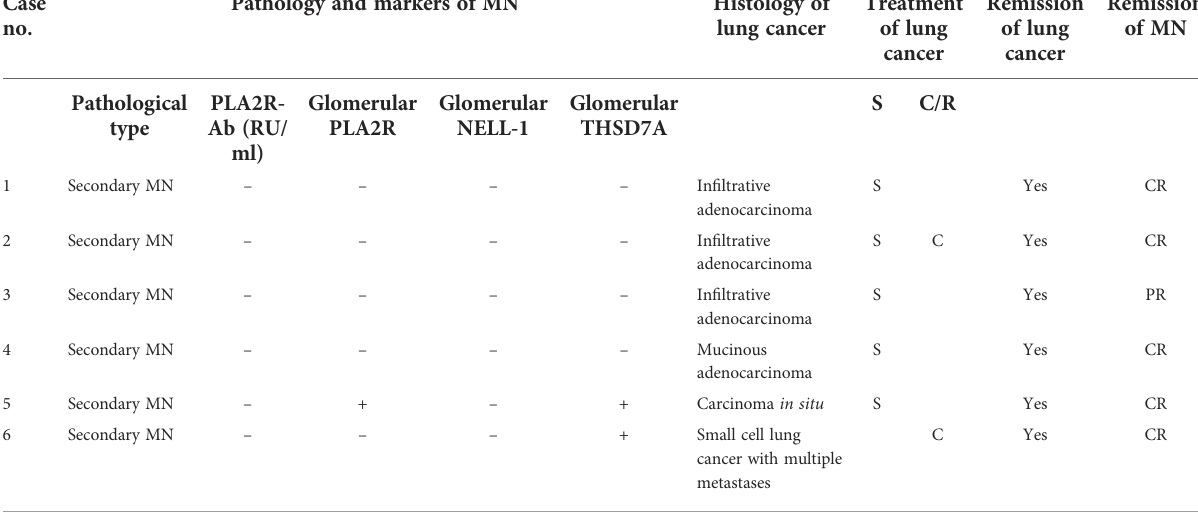
TABLE 3 Clinical and pathological features of lung cancer patients with nephropathy as the fi rst manifestation. Case